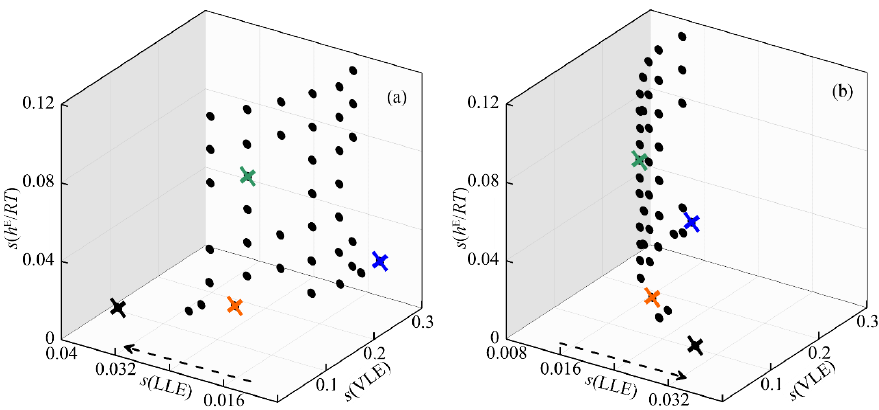
Figure 9. Two different views ( a , b ) according to the arrows of the efficient front obtained with the ε -constraint methodology. Selected parametrizations for the NRTL model: (P1) ; (P2) ; (P3) ; (P4) .